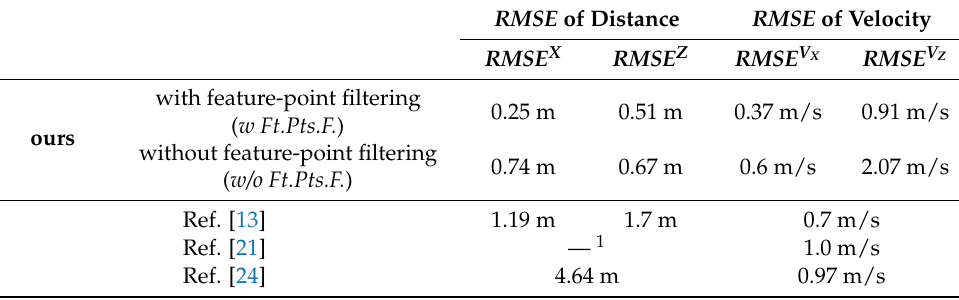
Table 3. The RMSE comparisons of our method with the state-of-the-art